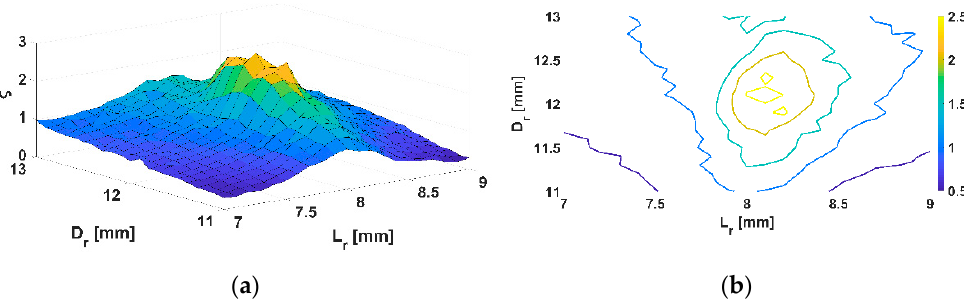
Figure 6. Relative PA signal of the finer resonance cylinder sweep (a) along with a contour plot (b). The color scale gives the values of 𝜍 .